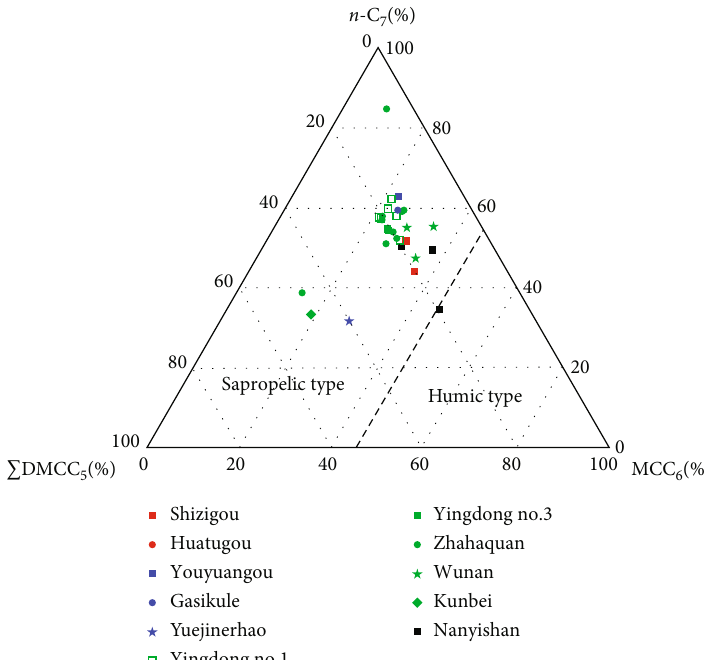
Figure 6: Ternary diagram of C